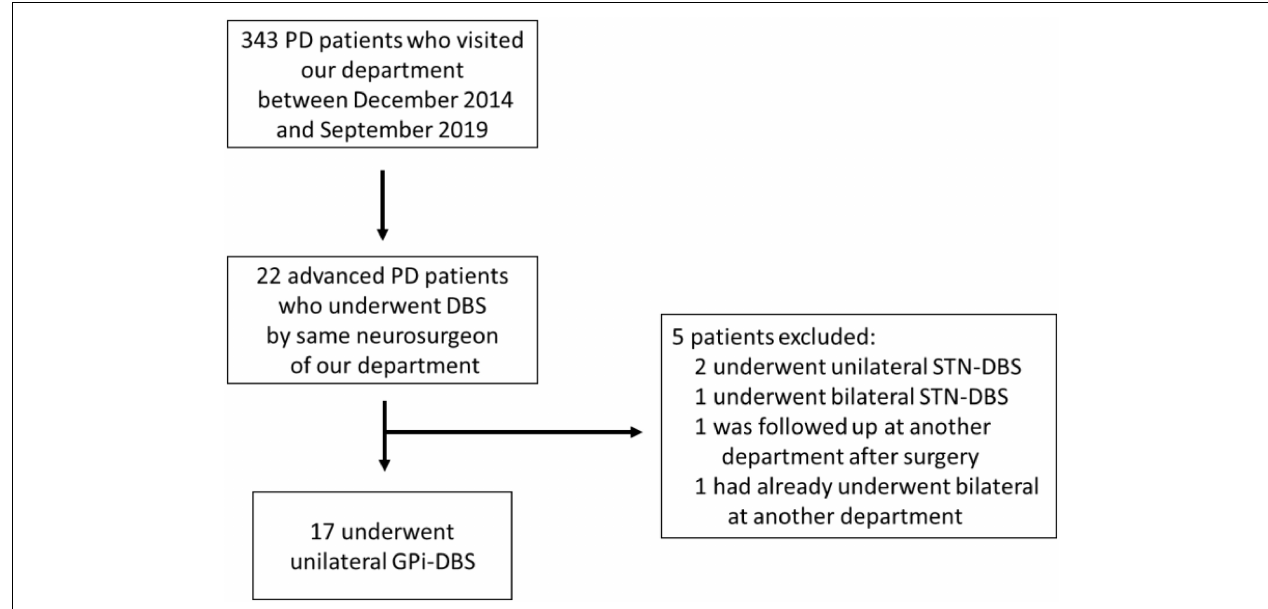
FIGURE 1 | Flow chart of the